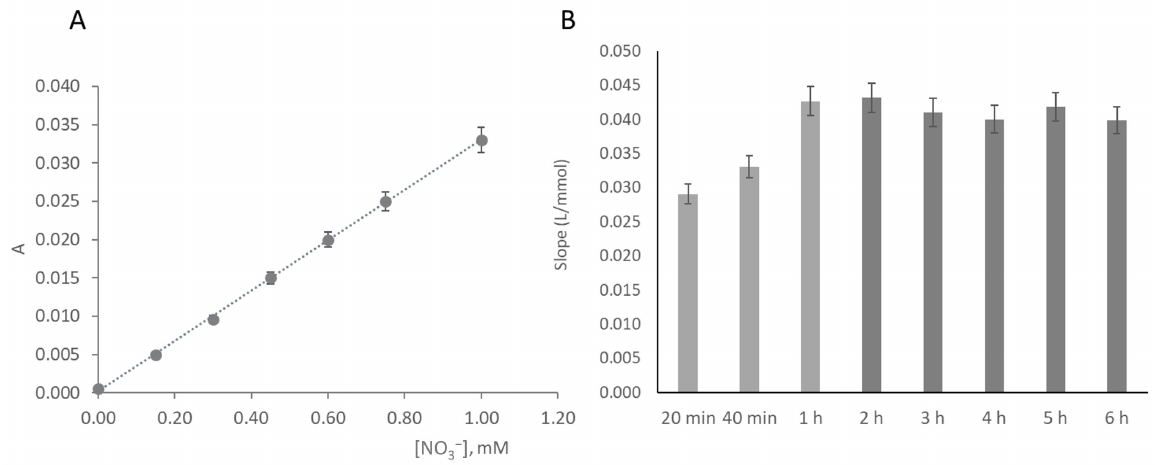
Figure 4. Calibration curve for the nitrate determination obtained with the developed µ PAD: ( A ) calibration curve plotting; ( B ) calibration curve slope at increasing scanning times; light grey bars represent calibration curves with a correlation coefficient >0.99; dark grey bars represent calibration curves with a correlation coefficient